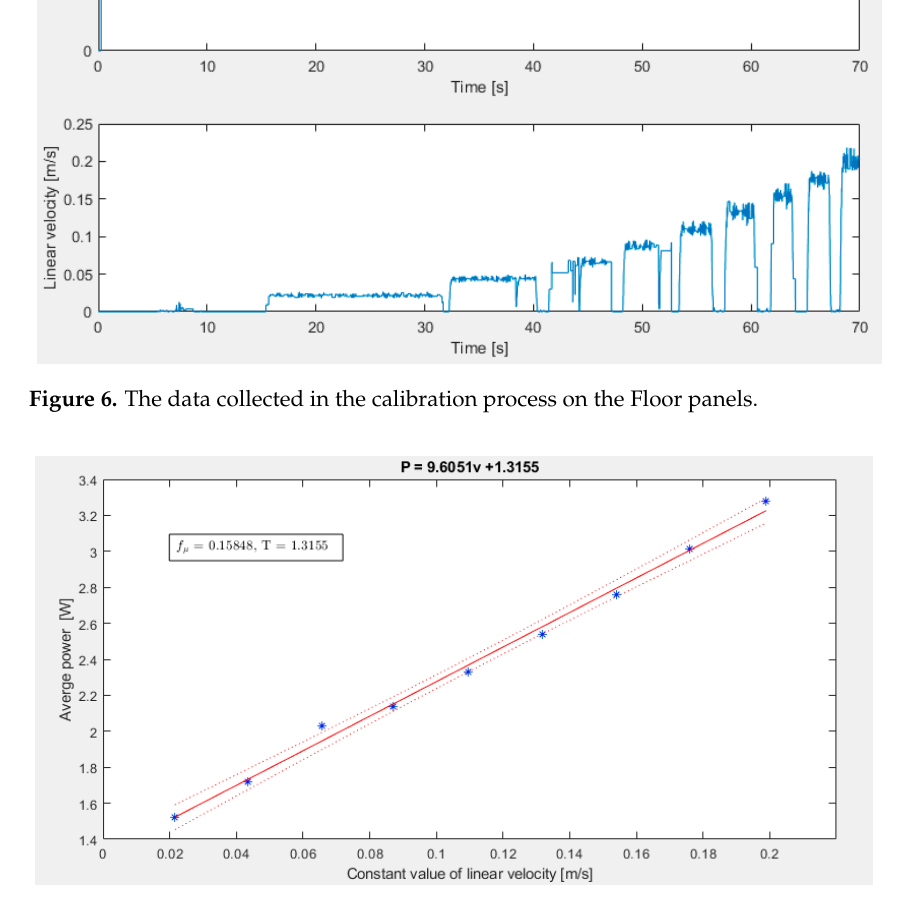
Table 3. The calculated coefficients for the differential drive mobile robot.